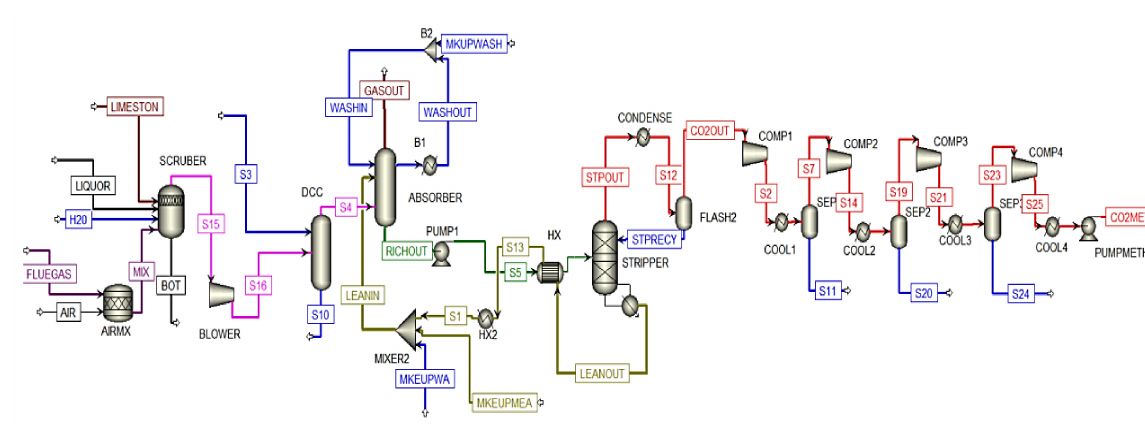
Figure A3. Cross heat exchanger duty.